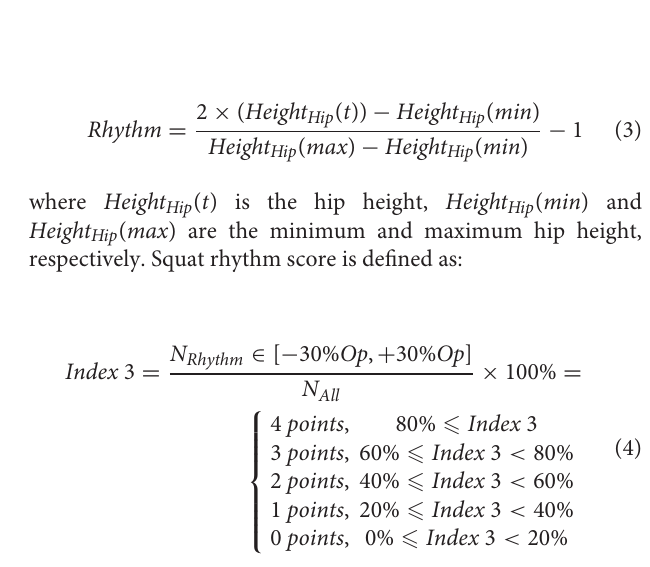
FIGURE 3 | Squat indices. Panels (A,B) show the image and pose estimation during squat exercise; panels (C–E) indicate Index 1; panels (F–H) indicate Index 2; panels (I–K) indicate Index